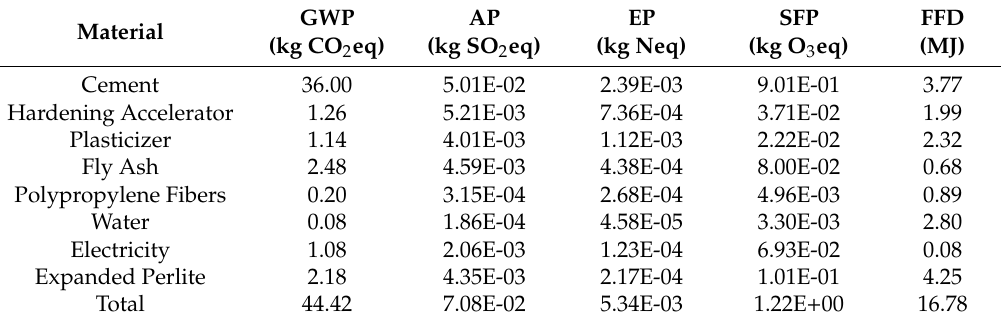
Table 7. Breakdown of material environmental impact contribution of S-4.